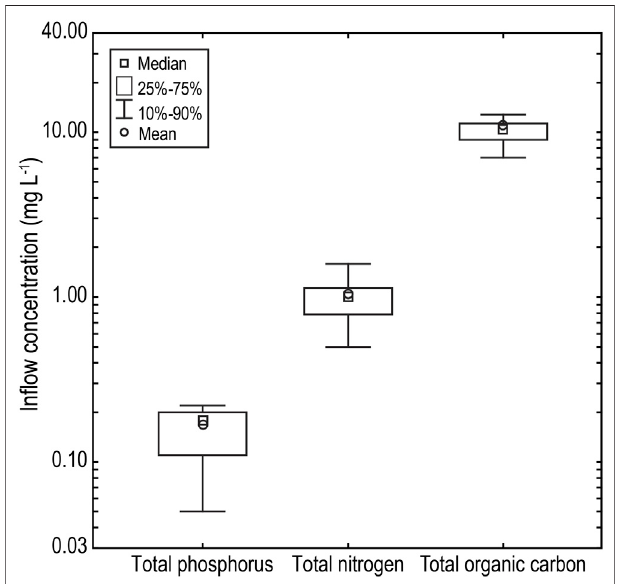
FIGURE 5 | Macronutrient (TP, TN and TOC) concentration of catchment in fl ow waters to Little Nerang Dam over a 5 year monitoring period from 2009 to 2013.